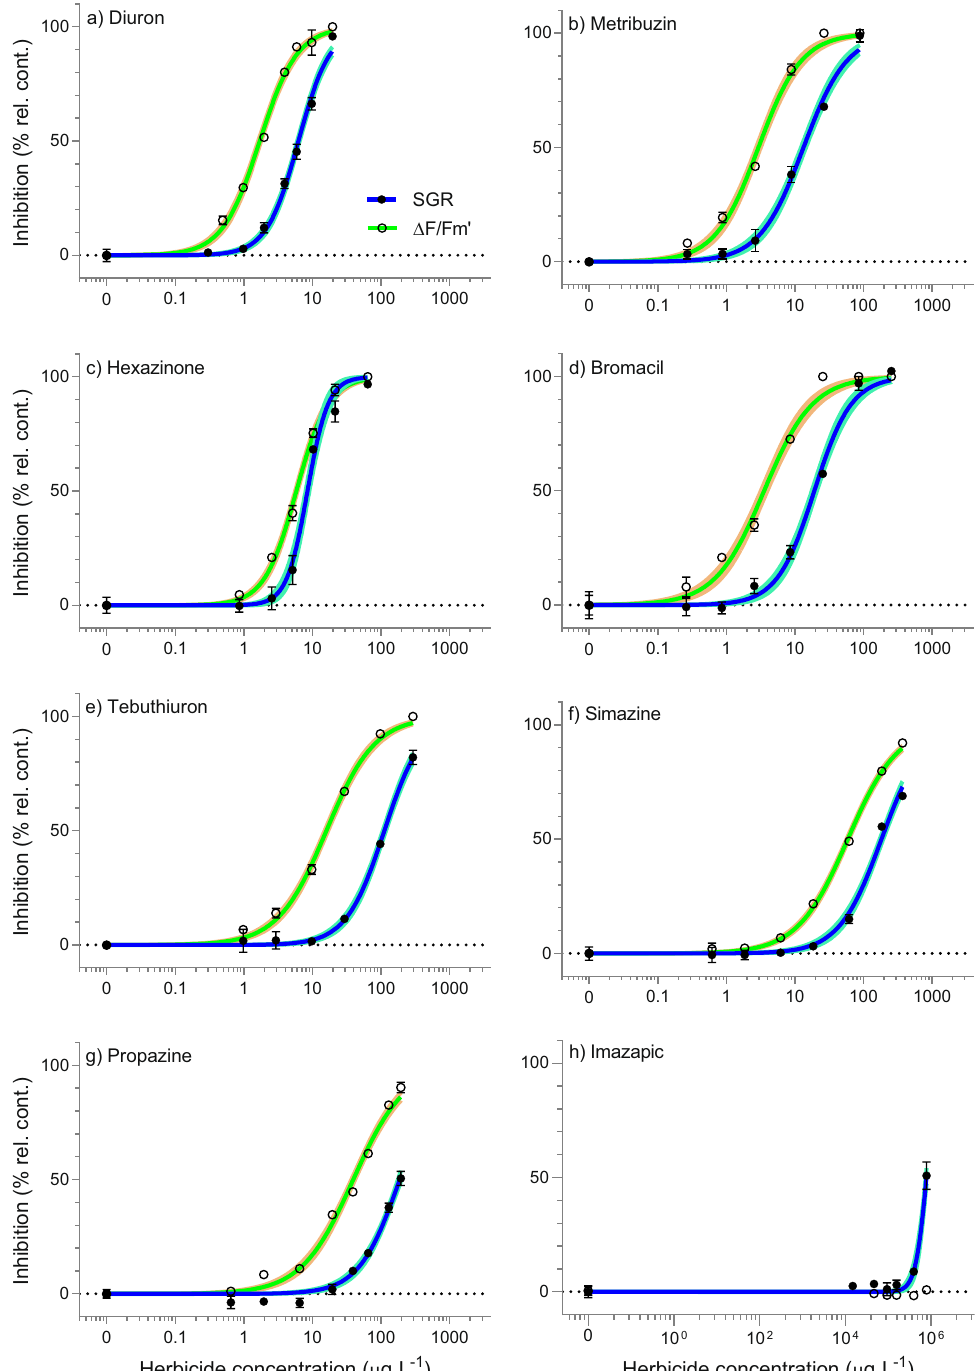
Figure 1. Concentration-response curves for EC x derivation. Sigmoidal, 4-parameter curve fit (solid line) and 95% confidence intervals (shaded area) on the relative percent inhibition of 3-day specific growth rate (SGR; full ring, mean ± SE) and 24 h effective quantum yield ( Δ F/F m ′ ; open ring, mean ± SE) following herbicide exposure to ( a ) diuron; ( b ) metribuzin; ( c ) hexazinone; ( d ) bromacil; ( e ) tebuthiuron; ( f ) simazine; ( g ) propazine; and ( h ) imazapic at increasing concentrations. All concentrations in µ g L − 1 (n = 5 for each treatment, bars not visible are smaller than